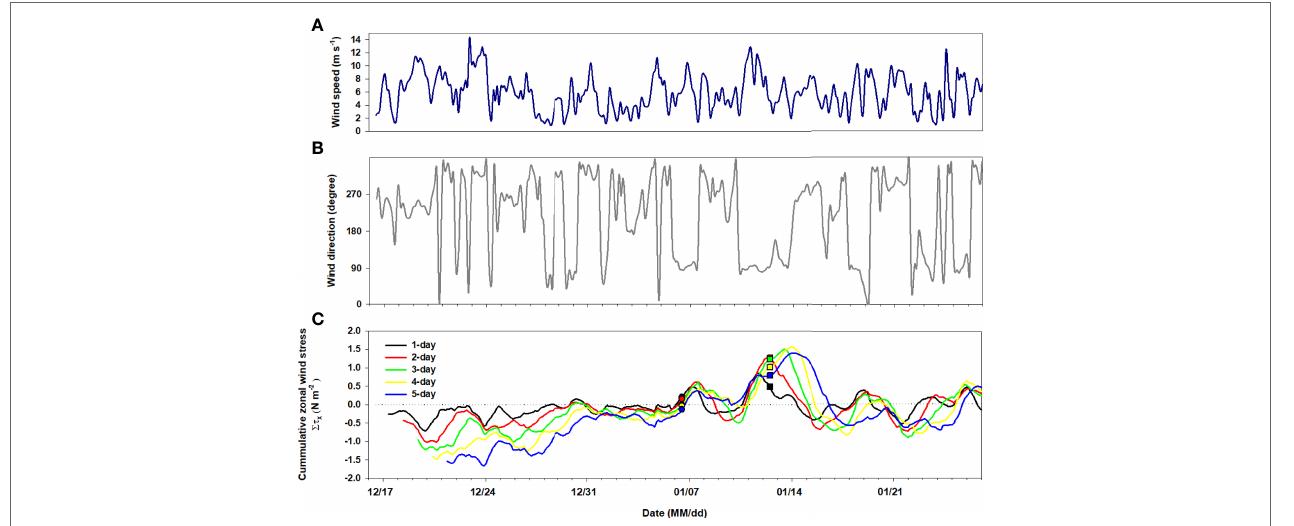
FIGURE 3 | Time series of (A) wind direction, (B) wind speed and (C) cumulative zonal wind stress during sampling period. In ( C) , the black line indicates the prescribed climatological wind stress ( τ x ) for the 1-day. The red, green, yellow, and blue lines are cumulative wind stress forcing for 2-, 3-, 4-, and 5-day, respectively. The circle and square symbols represent the sampling time of January 6 and 12, respectively.